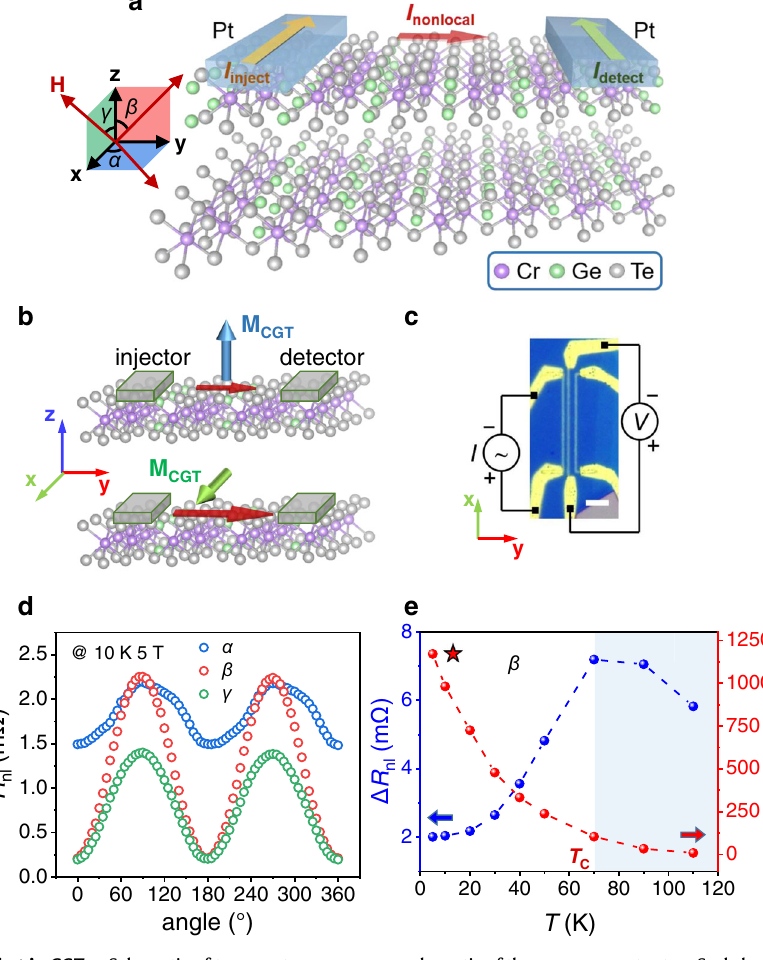
schematicofthemeasurementsetup.Scalebar:5 μ m. d Angle-dependentnonlocal resistance R nl as the magnetic fi eld rotated in xy plane ( α , blue), yz plane ( β , red) and xz plane( γ ,green)at10Ktemperaturewith5Tmagnetic fi eld. e Temperature- dependent nonlocal MR (red) and the range of nonlocal resistance ( Δ R nl , blue) as the magnetic fi eld rotated in yz plane ( β